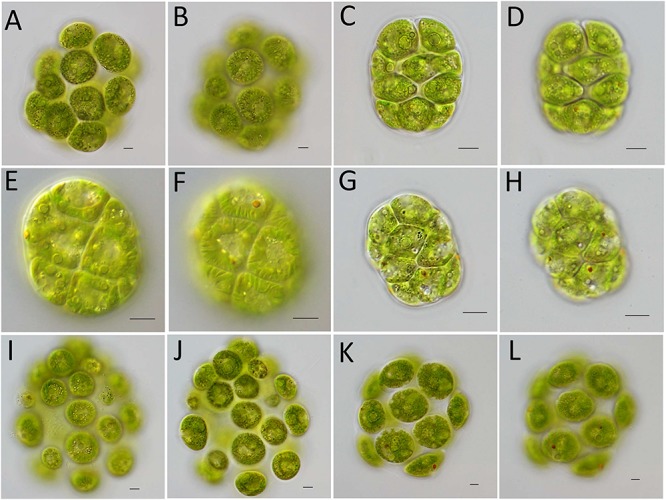
Light microscopy of vegetative colonies of six species of colonial volvocine algae. (A,B)
Colemanosphaera charkowiensis, strain FACHB-2326. (A) The chloroplast had more than two pyrenoids of almost identical size. (B) Only two contractile vacuoles distributed near the base of the flagella, the chloroplast had prominent longitudinal striations. (C,D)
Volvulina compacta, strain FACHB-2337. (C) Colony ellipsoidal in shape, cells were embedded in a gelatinous matrix formed a hollow sphere. (D) Cells were more or less contiguous and appeared nearly tetragonal by mutual compression. (E,F)
Pandorina colemaniae, strain FACHB-2361. (E) The chloroplast had more than two pyrenoids. (F) Colony were ellipsoidal in shape and contained 8 cells compactly arranged in a gelatinous matrix. (G,H)
Pandorina morum, strain FACHB-2362. (G) The chloroplast contained a single, basal pyrenoid. (H) Colony were ellipsoidal in shape and contained 8 cells compactly arranged in a gelatinous matrix. (I,J)
Colemanosphaera angeleri, strain FACHB-2363. (I) Only two contractile vacuoles distributed near the base of the flagella. (J) The chloroplast contained a large basal pyrenoid and small pyrenoids. (K,L)
Yamagishiella unicocca, strain FACHB-2364. (K) The chloroplast only contained a single, basal pyrenoid. (L) Only two contractile vacuoles distributed near the base of the flagella. Scale bars: 10 μm.